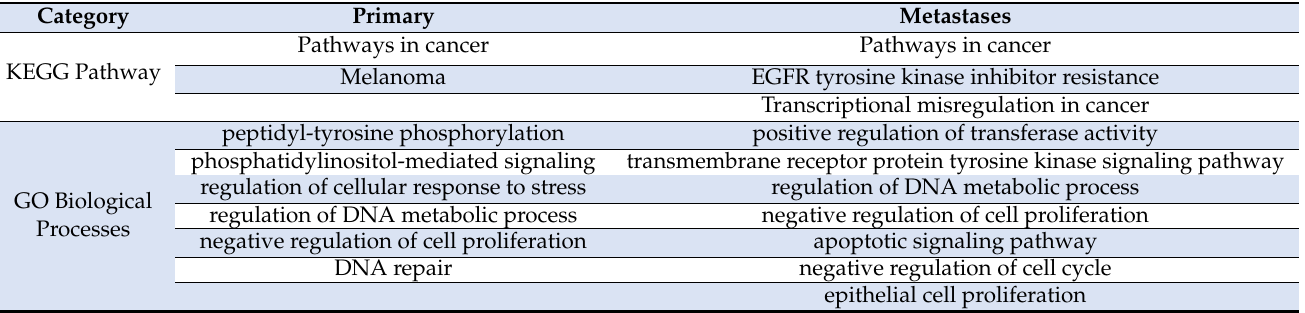
Table 3. The analysis of KEGG and